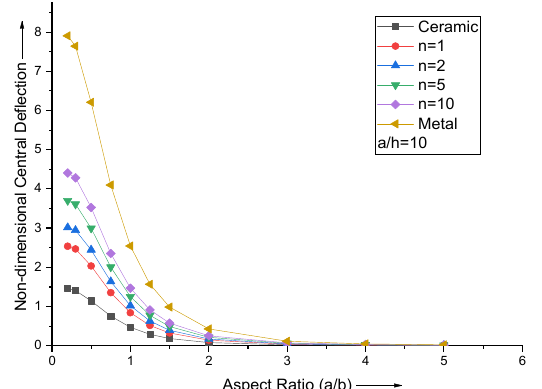
Figure 2. Effect of vole fraction index (n) on non − dimensional central deflection of the plate. The effect of the aspect ratio of the FGM plate is investigated by varying aspect ratio and volume fraction index fixing a/h = 10. The dependence of plate’s non-dimensional central deflection on the a/b ratio is depicted in Figure 3. It is observed that the effect of change in aspect ratio a/b becomes negligible after a/b = 3. It is more prominent when a/b < 1.